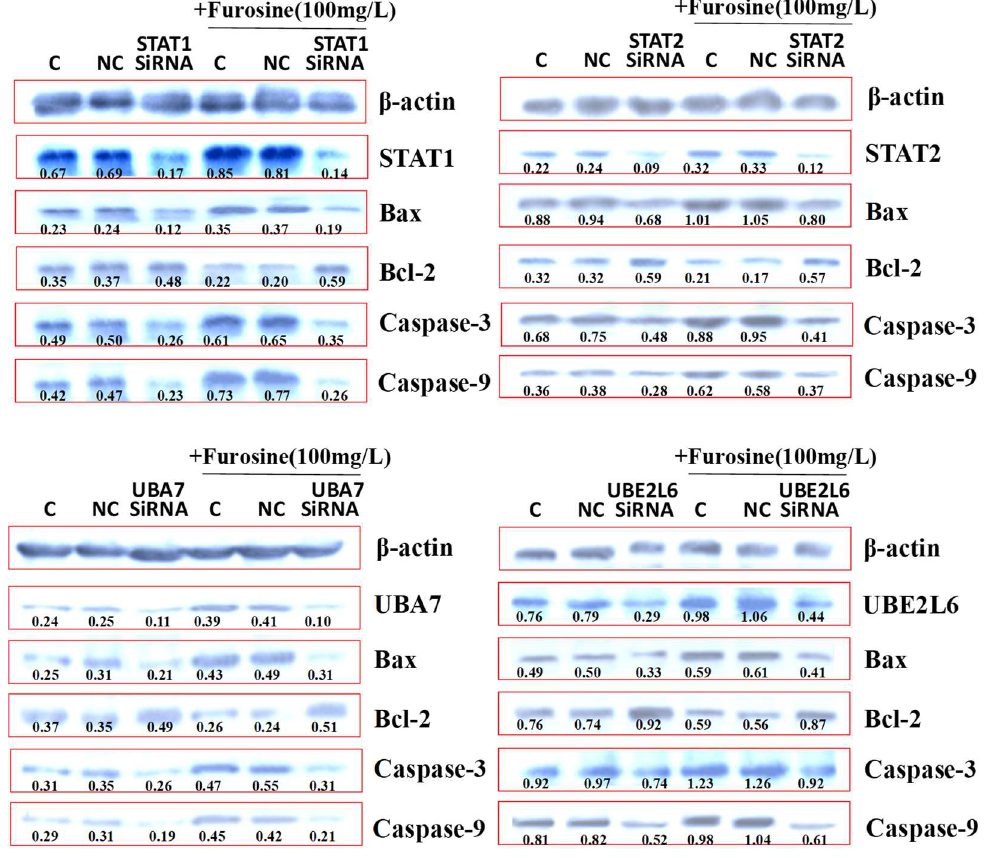
Figure 5. Proteins expression of STAT1/2 , UBA7 , UBE2L6 , Caspase-3 , Bcl-2 , Bax , and Caspase-9 treated with of SiRNA and furosine. The values of biochemical indicators were represented as mean . C stands for control, and NC stands for group treated with control SiRNA.